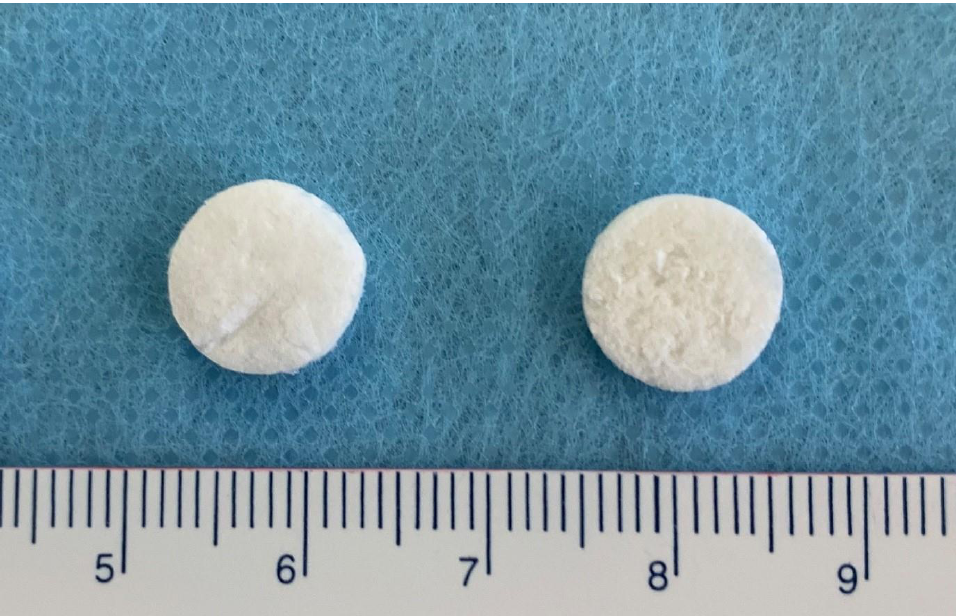
Figure 2. CM (left) and mCM (right) pre-shaped for implantation (φ= 10mm, thickness = 2mm).